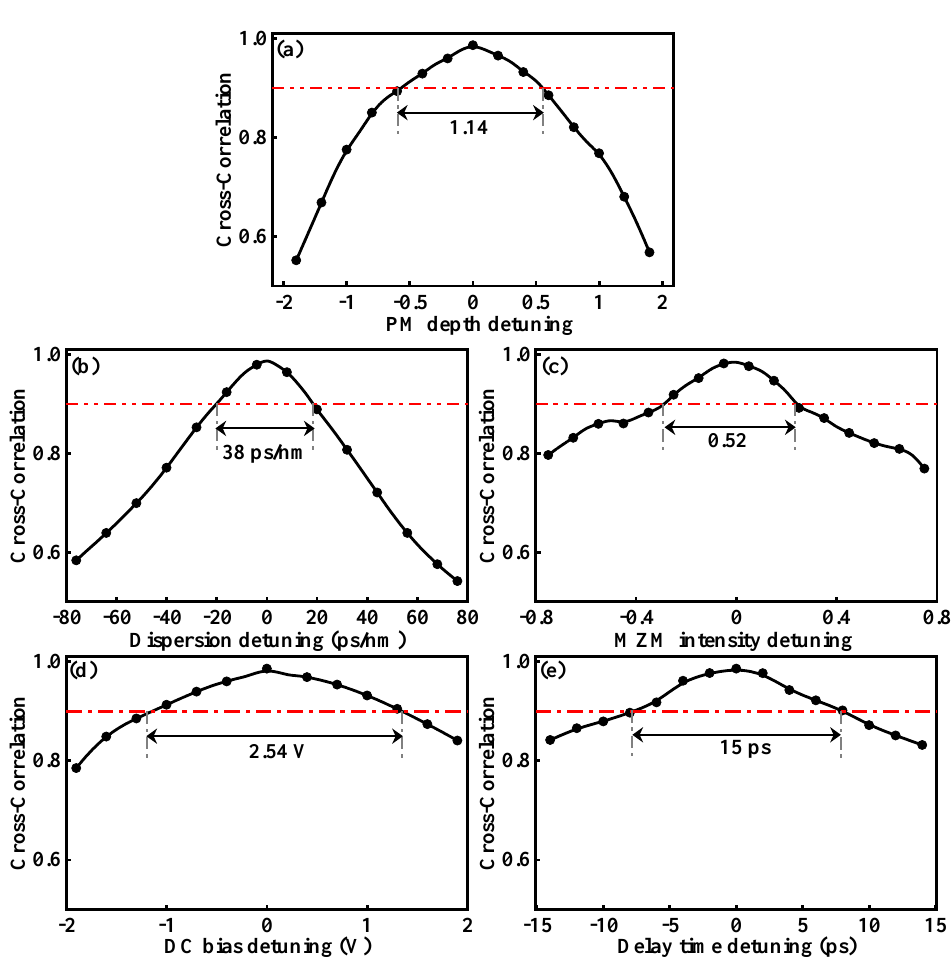
Figure 6. Cross-correlation between Alice and Bob versus ( a ) PM depth detuning, ( b ) dispersion detuning, ( c ) MZM intensity detuning, ( d ) DC bias detuning, and ( e ) delay time